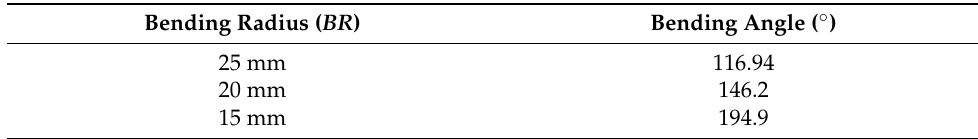
Figure 18. Bending analysis of the prototype antenna ( a ) BR = 25 mm, ( b ) BR = 20 mm, ( c ) BR = 15 mm. Table 1. Bending angles at different bending